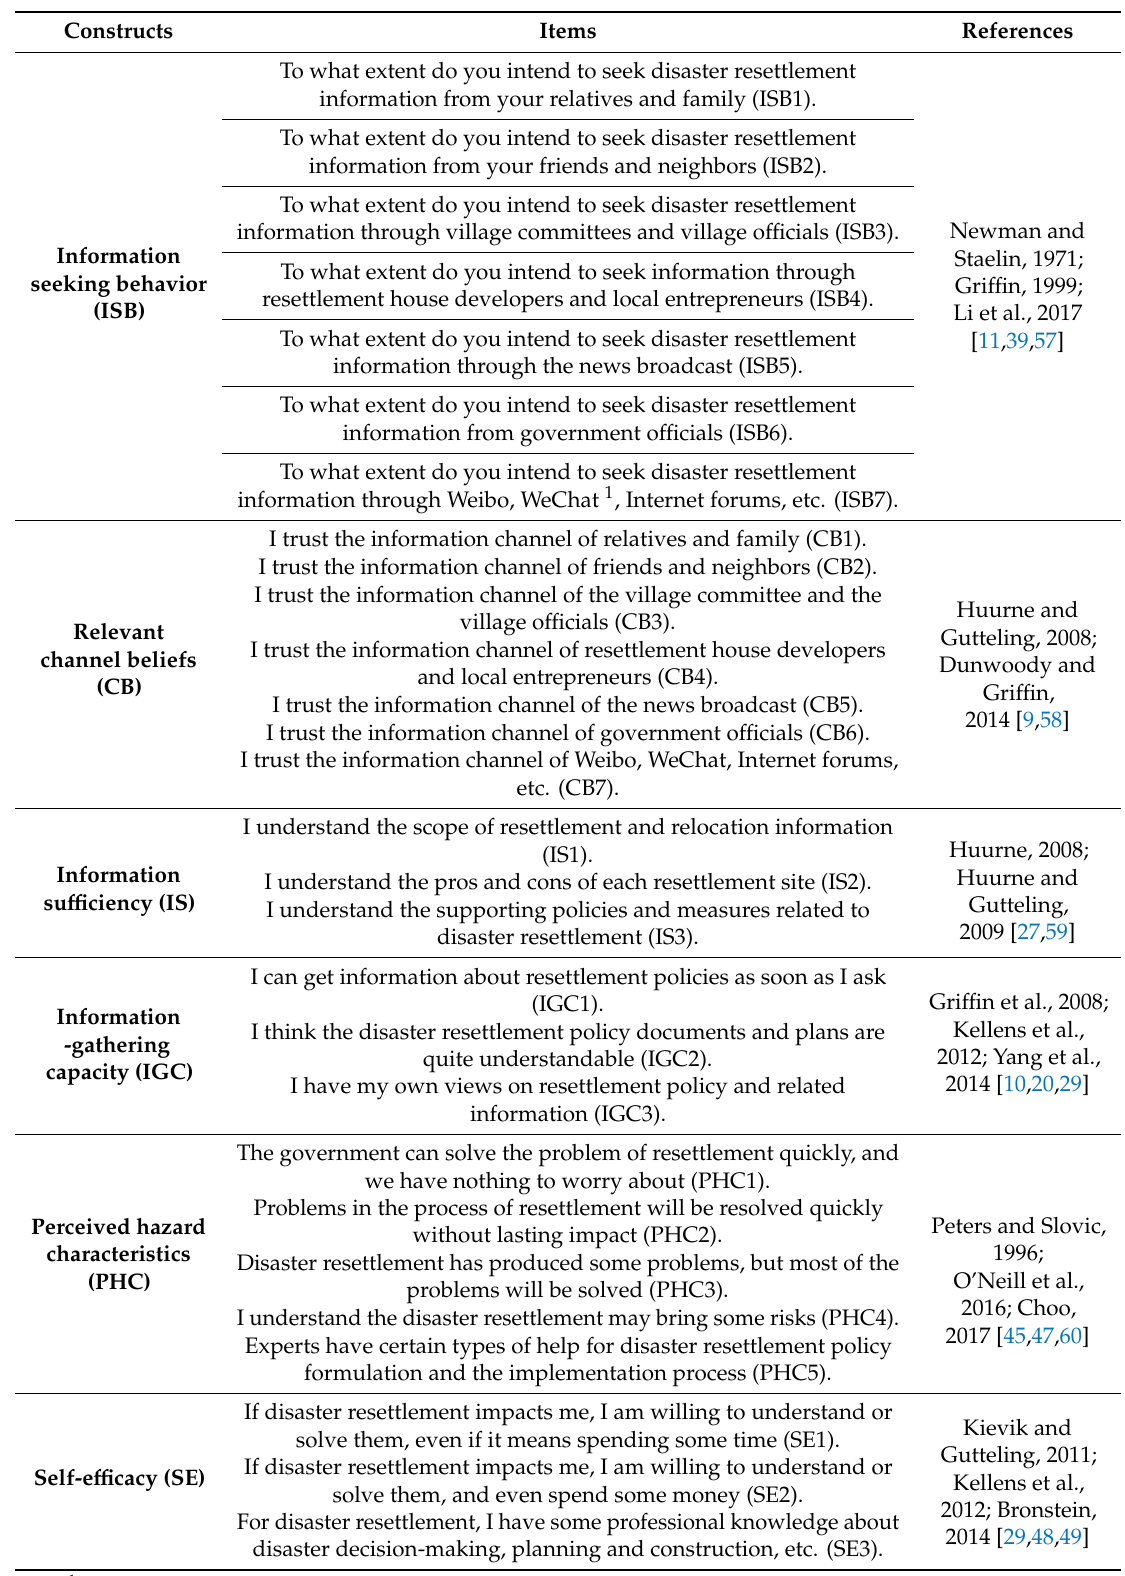
Table 1. Constructs, items, and